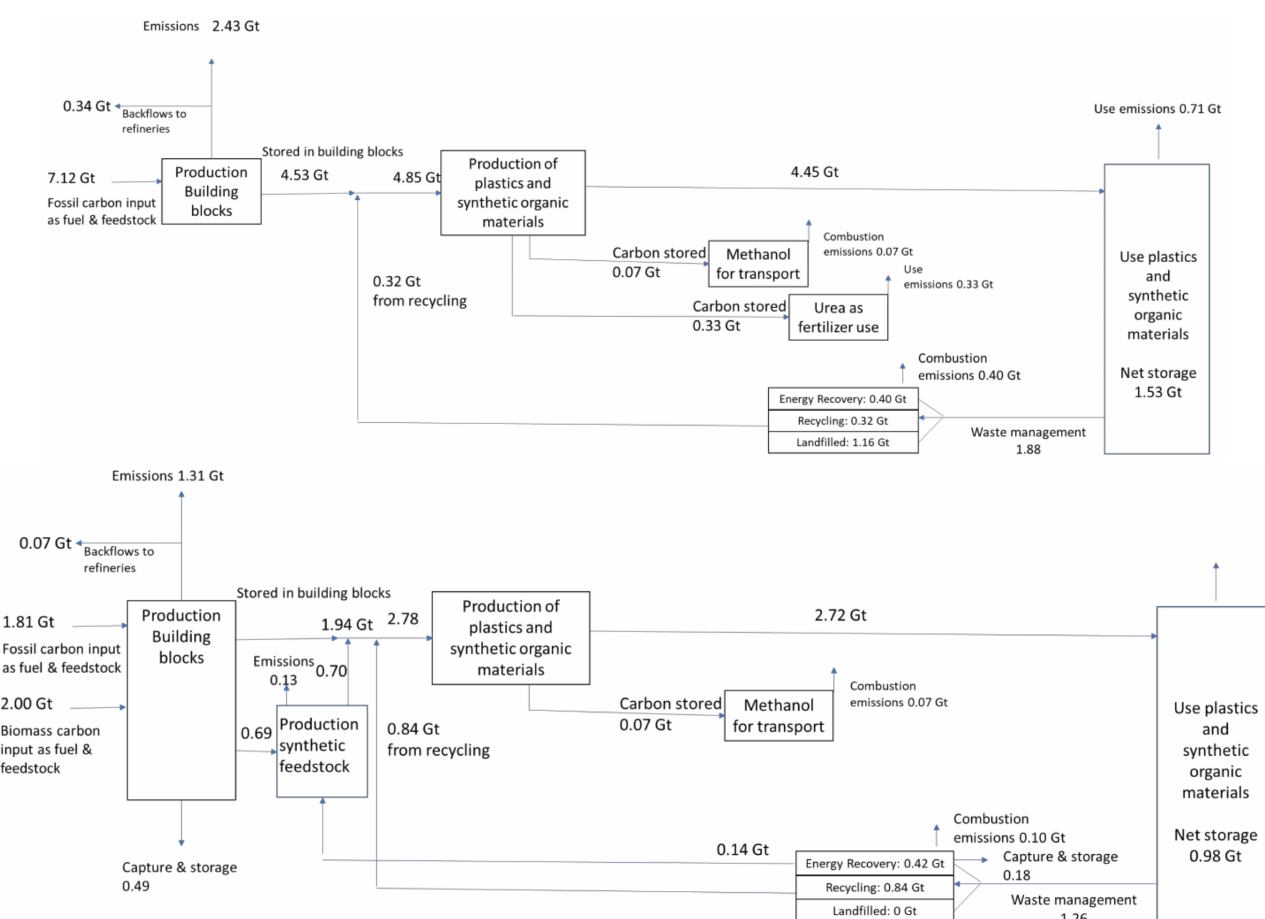
Figure 9. Embodied carbon flows for chemicals and petrochemicals in the PES and the 1.5 ◦ C case in 2050. Figures refer to CO 2 equivalent